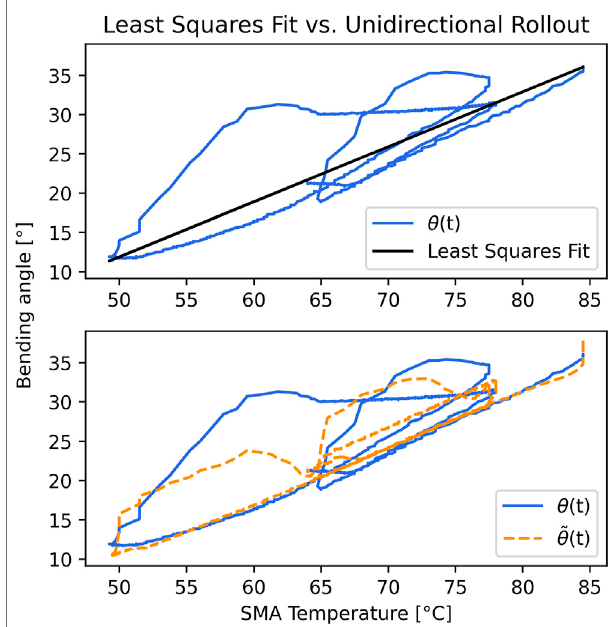
FIGURE 7 | Demonstration of improved hysteresis characterization predicted from ~ θ rollout prediction on unidirectional bending trained on u 1 and T 1 . The LSTM captures some hysteretic effects over time whereas a naive least-squares comparison does not.